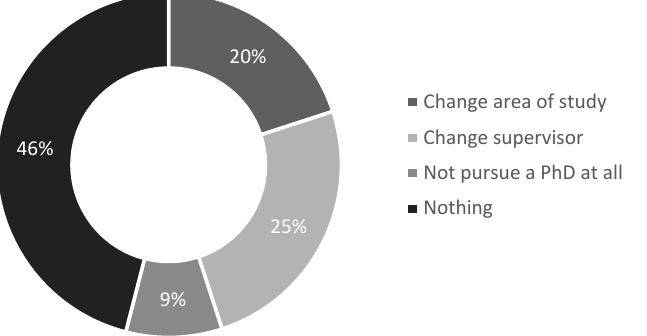
Figure 1. What would you do differently right now if you were starting your PhD program? Distribution of respondents ( n = 6320).